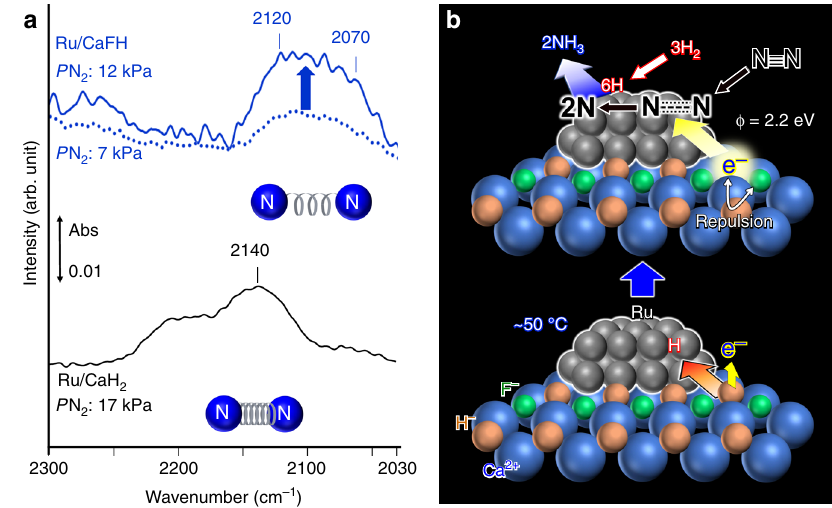
Fig. 5 FT-IR spectra and a possible reaction mechanism. a FT-IR spectra for N 2 adsorption on Ru/CaFH and Ru/CaH 2 after ammonia synthesis reaction at 340 °C, followed by cooling down below 20 °C. The FT-IR spectra were measured according to previous reports 19 . N 2 was adsorbed on the catalysts at 25 °C in the presence of N 2 (6 – 15 kPa). N ≡ N stretching ( ν N 2 ) bands were not observed in both catalysts under vacuum. b Proposed reaction